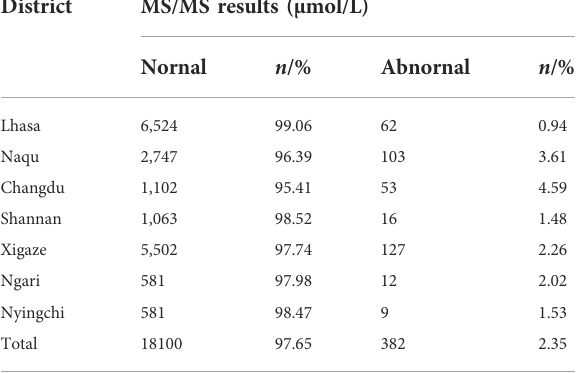
TABLE 3 Statistics of recall rate in Tibet refer to the P5%~95% values.